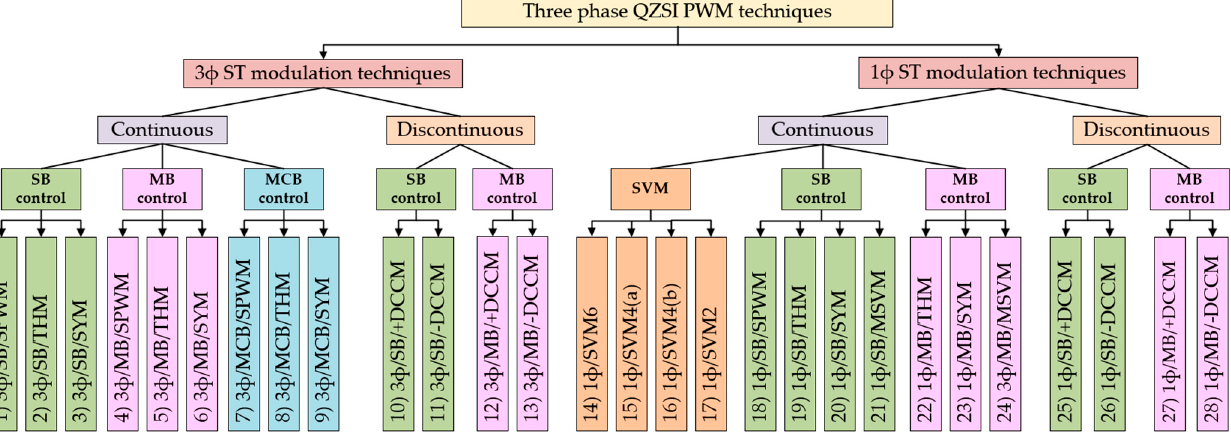
Figure 7. Classification of modulation techniques [47–50].